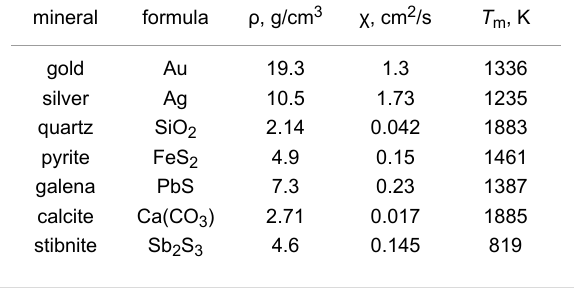
Table 1: Physical parameters of the minerals from gold ore.